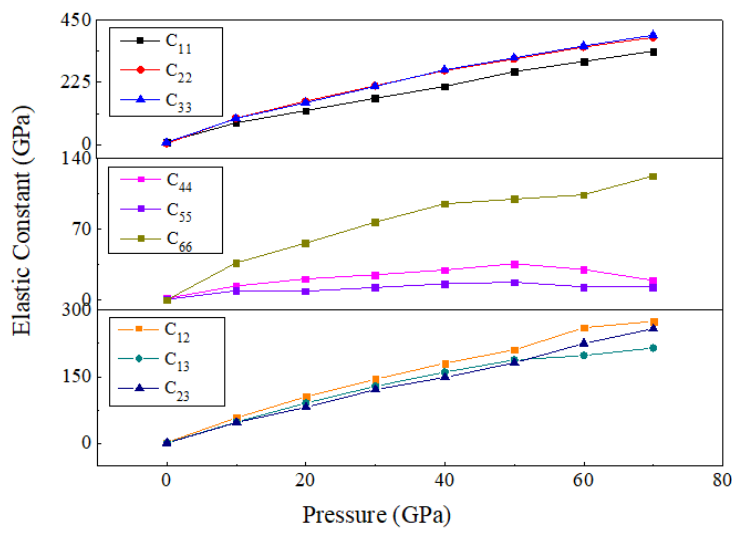
Figure 3. The elastic constants of DNTF under different pressure.